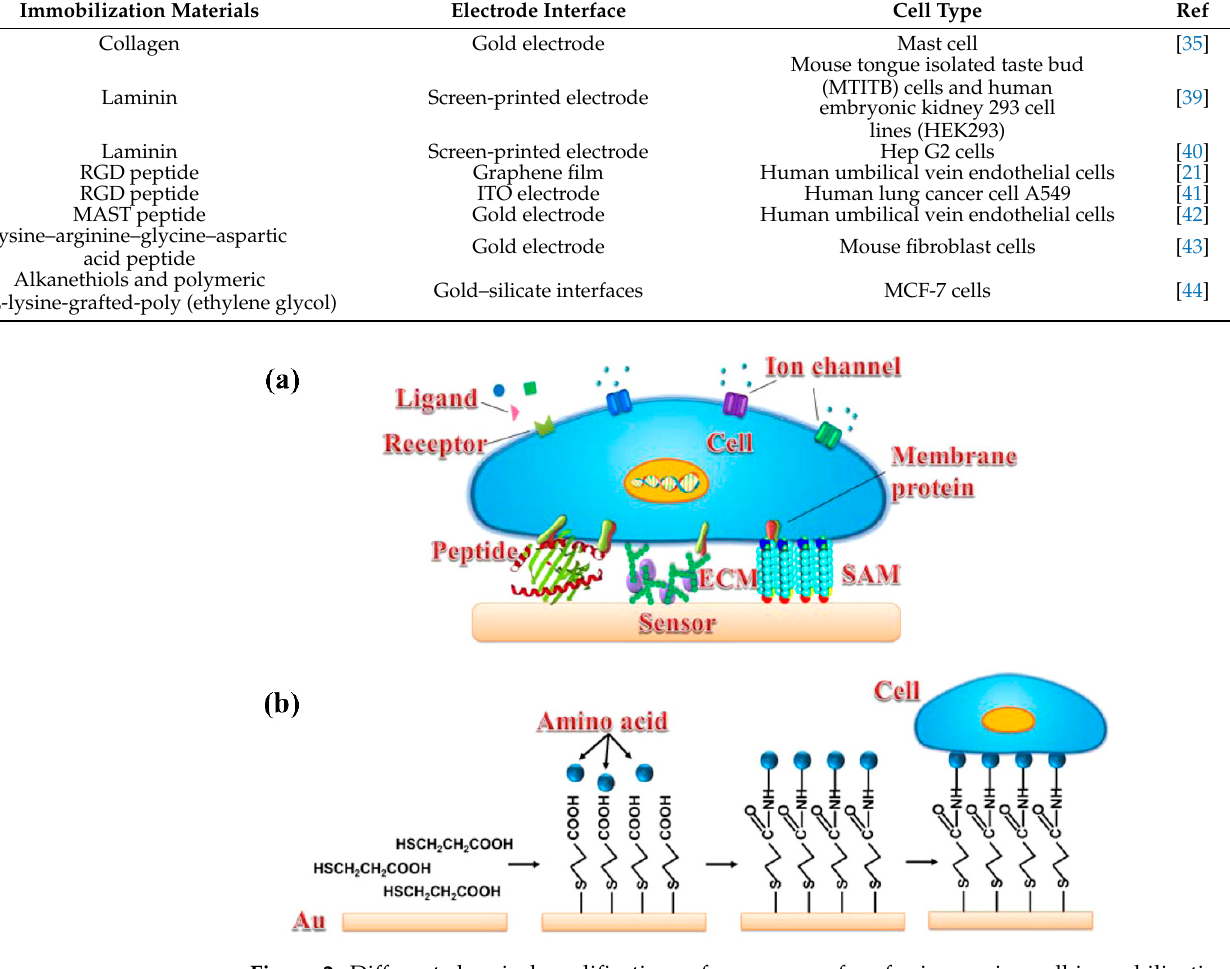
Figure 2. Different chemical modifications of a sensor surface for improving cell immobilization efficiency. ( a ) Schematic diagram of a cell coupled with a sensor surface by different surface modifica- tions, including peptide, ECM, and SAM. ( b ) Schematic of the chemical process of cells immobilized on a gold surface via SAM [38]. Copyright © 2014, American Chemical